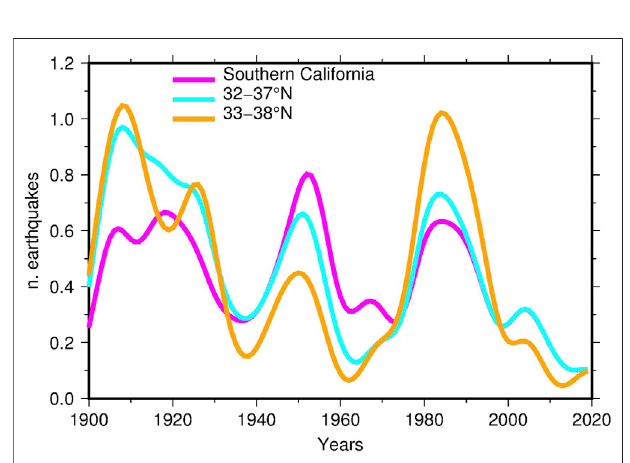
FIGURE8 | Time density of earthquakes for a north/south partitioning of the territory (red lines) compared with the trend of PDSI averaged over the climate zones 6 and 7 (all the curves obtained by Gaussian kernel smoothing using a bandwidth smoothing parameter h (cid:1) 4 years). The earthquake time densities were anticipated by 10 years (northern sector, thick red line) and 4 years (southern sector, thin red line) in order to maximizethe correlation with PDSI (see also the results for the data sets 4 and 6 in Table 1 ).